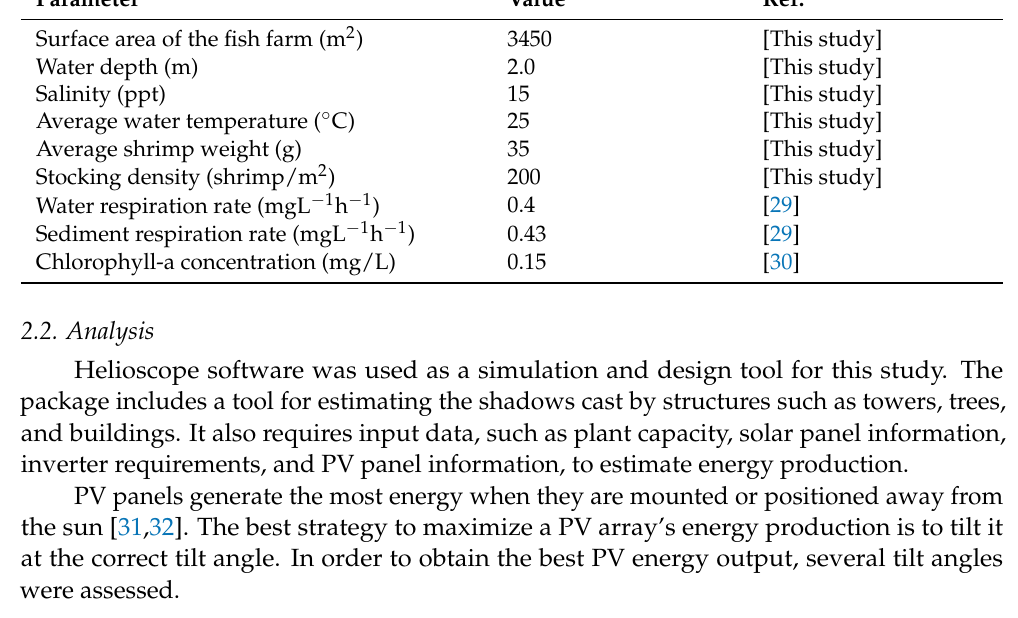
Table 1. Biophysical characteristics of the shrimp farm.